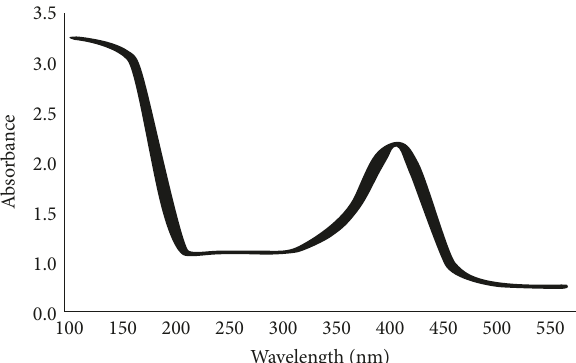
Figure 5: The absorbance of biosynthesized AgNPs using UV-vis spectrum.